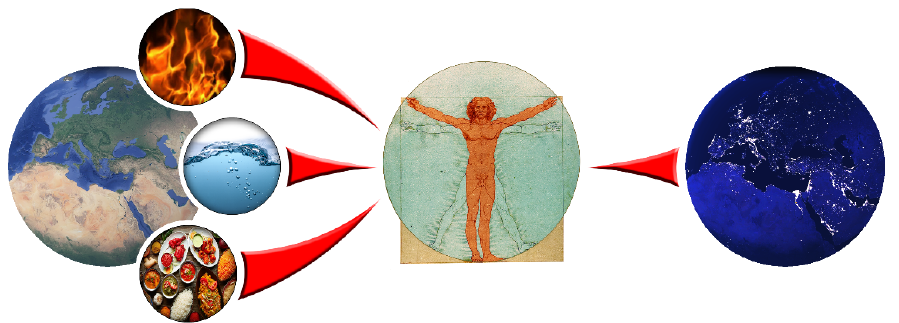
Figure 3. An attempt at an artistic representation of issues of prosperity. WEF–Land nexus ( left ) and the dynamics of cities’ clustering by night ‐ light satellite image ( right ). the dynamics of cities’ clustering by night-light satellite image ( right